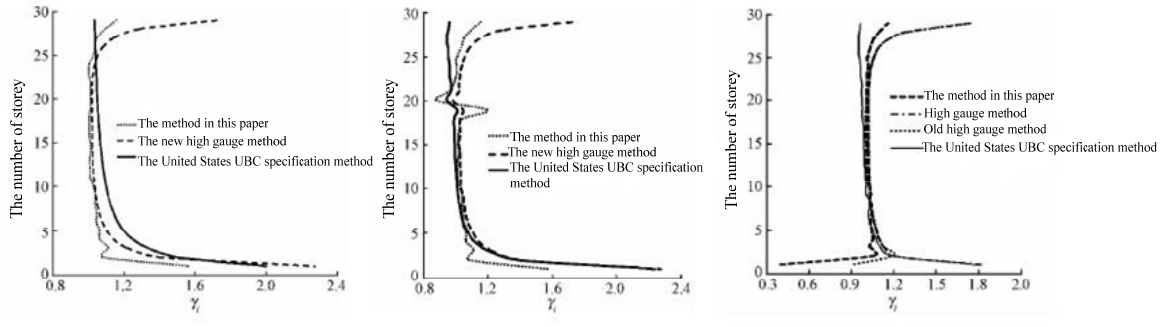
Figure 5: The comparison of the lateral layer stiffness ratio